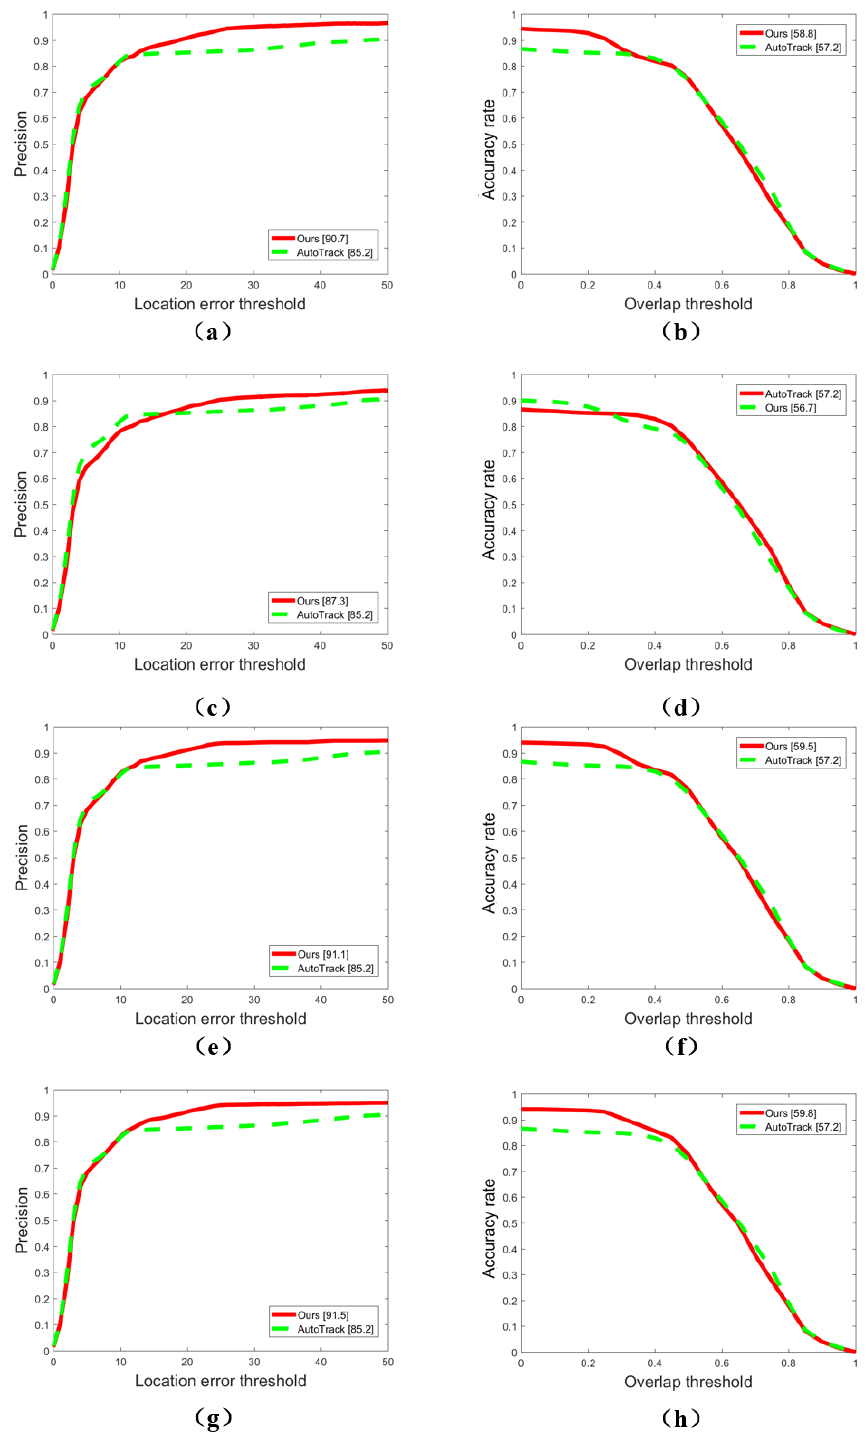
Figure 3. Comparison of total precision and total accuracy under different weights. ( a ) is the precision when α = 0.4, β = 0.6, ( b ) is the accuracy when α = 0.4, β = 0.6, ( c ) is the precision when α = 0.3, β = 0.7, ( d ) is the accuracy when α = 0.3, β = 0.7, ( e ) is the precision when α = 0.2, β = 0.8, ( f ) is the accuracy when α = 0.2, β = 0.8, ( g ) is the precision when α = 0.1, β = 0.9 and ( h ) is the accuracy when α = 0.1, β =